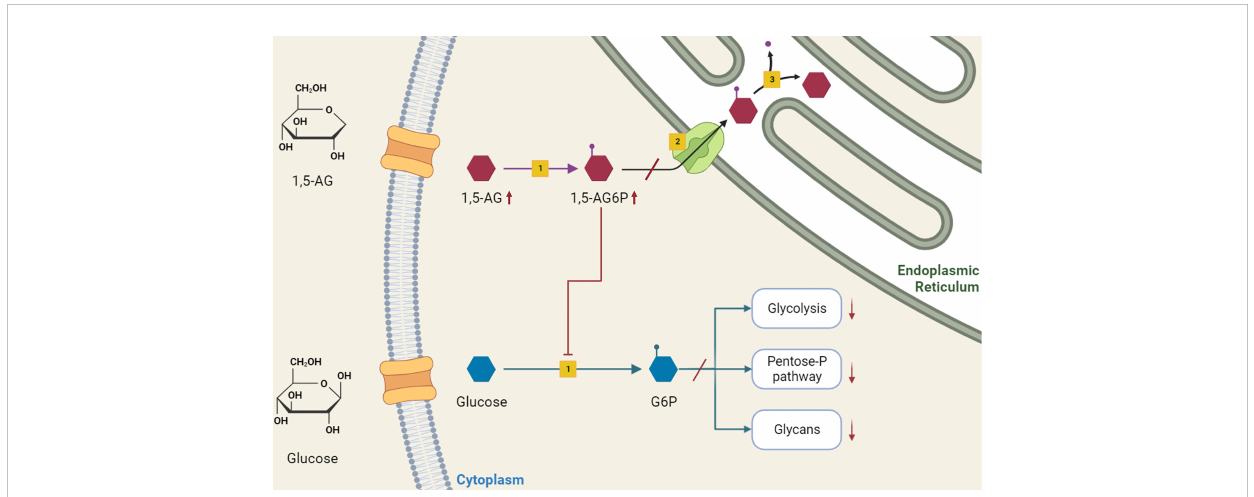
FIGURE 1 Role of 1,5-anhydroglucitol-6-phosphate accumulation in neutropenia and neutrophil dysfunction of G6PT de fi ciency. 1,5-AG, normally present in blood, enters into neutrophils where is slowly phosphorylated by a side activity of hexokinases [1] into 1,5-AG6P. G6PT [2] transports 1,5-AG6P into the endoplasmic reticulum, where it is dephosphorylated by G6PC3 [3]. In GSDIb patients, the de fi ciency of G6PT leads to 1,5-AG6P accumulation, which in turn inhibits hexokinase activity. This inhibition affects the conversion of glucose into G6P, interfering with downstream metabolic pathways of glycolysis, pentose-phosphate pathway and glycosylation, with consequent impaired neutrophil survival, respiratory burst and protein